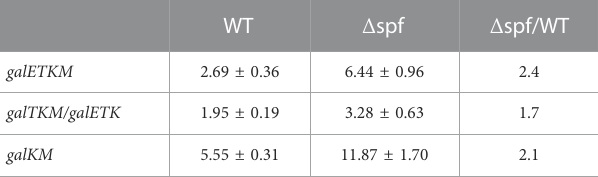
TABLE 2 The half-life of the 3 9 -sharing mRNA. These were measured from the K-probed blots.The values arethe average of threeindependentexperiments.